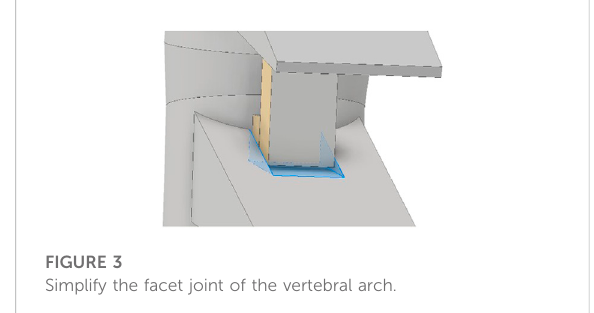
FIGURE 3 Simplify the facet joint of the vertebral